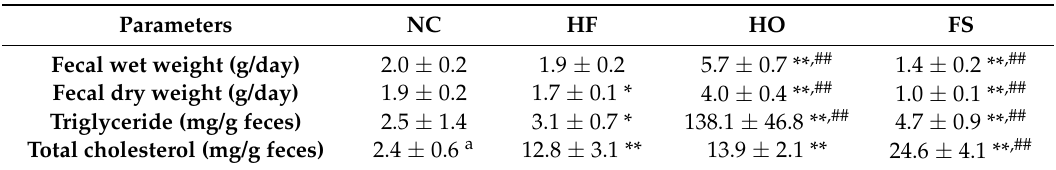
Table 6. The changes of fecal weight, triglyceride, and total cholesterol levels of HF-diet-fed rats supplemented with or without orlistat and RMD for 8 weeks.